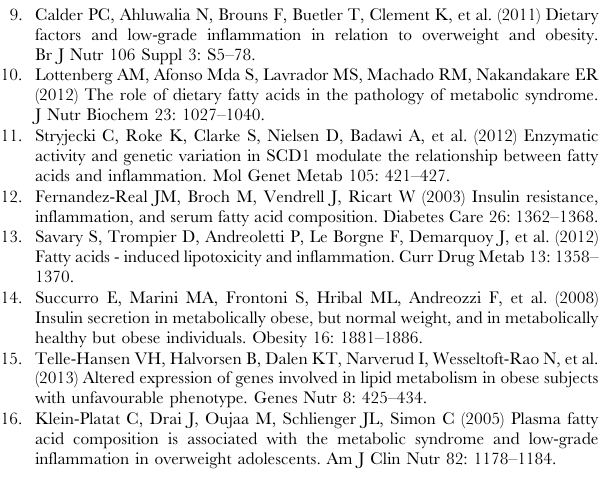
Table S2 Mean relative percentage of phospholipid and triglyceride fatty acids in serum. Relative fatty acid (FA) values were calculated as a % of all FAs detected and are reported Importance in Projection (VIP) greater than 1 (as determined